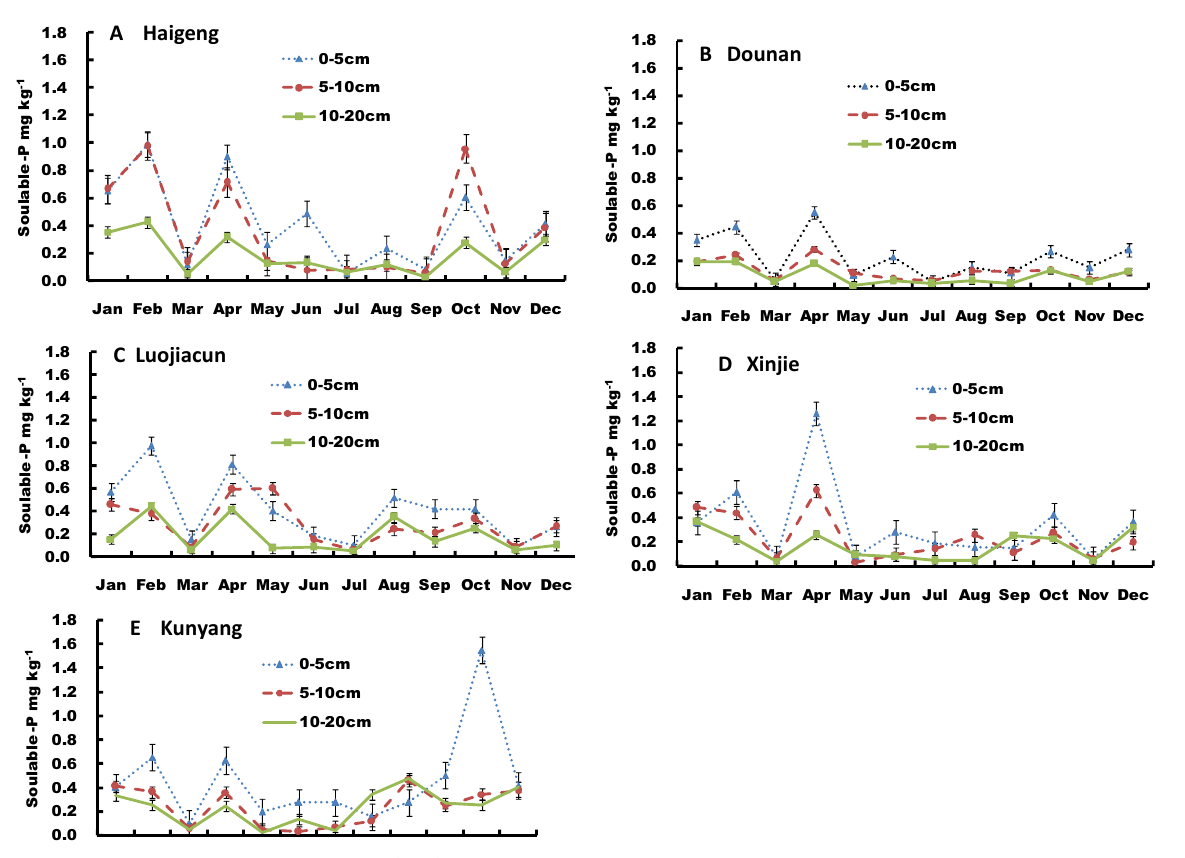
Figure 3. ( A – E ) Monthly variation in sediment soluble-P (S-SP) at different sites of Dianchi Lake. The variation of sediment soluble-P concentrations in different layers was highest in Luojiacun, ranging from 69% to 121%, followed by 71% to 100% in Xinjie and 73% to 97% in Haigeng, with low variation in Dounan ranging between 59% and 73% and Kunyang, ranging between 63% to 86%. During the sampling year, sediment soluble-P in different layers were higher from January to May in all sites, except for the Kunyang site, where the soluble-P peaked in November in the surface sediment and in September in the middle and bottom layers. 3.4. Variation in Surface Sediment-P and Water-P at the Sediment–Water Interface in Dianchi Lake The surface sediment available-P concentration and water total-P concentration var- ied among different sites during the sampling season (Figure 4). There was a significant negative correlation between sediment available-P concentrations and water total-P concen- trations at the Haigeng site (y (water total-P) = − 0.0037x (sediment available-P) + 0.5044, r = 0.598 *, p < 0.05, n = 12 in a year, * indicates significant correlation). However, this negative correlation was not apparent at other sites. In contrast, the changes in sediment available-P concentrations showed similar trends to the those in water total-P during most of the sampling period, except in May at the Luojiacun, Xinjie, and Kunyang sites.